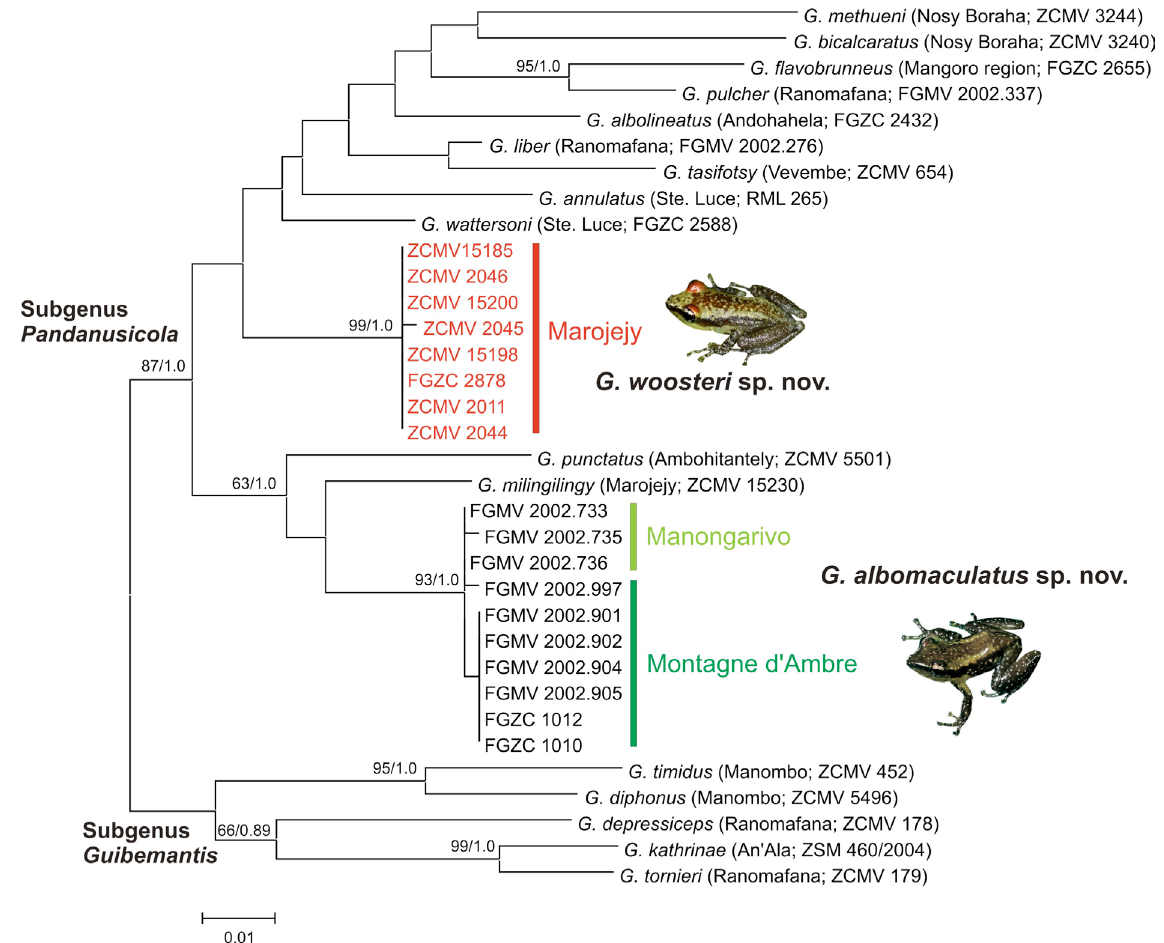
Fig. 1. Maximum Likelihood tree of species in the genus Guibemantis Dubois, 1992, subgenus Pandanusicola Glaw & Vences, 1994 (rooted with the nominal subgenus). The tree is based on an analysis of 535 bp of the mitochondrial 16S rRNA gene and contains representatives of all valid species of Guibemantis . Numbers at nodes are bootstrap proportions from a Maximum Likelihood bootstrap analysis (500 replicates) in percent (BP), and posterior probabilities (PP) from Bayesian Inference (only shown for nodes with either BP > 60% or PP > 0.95). Inset photos show the two new species described